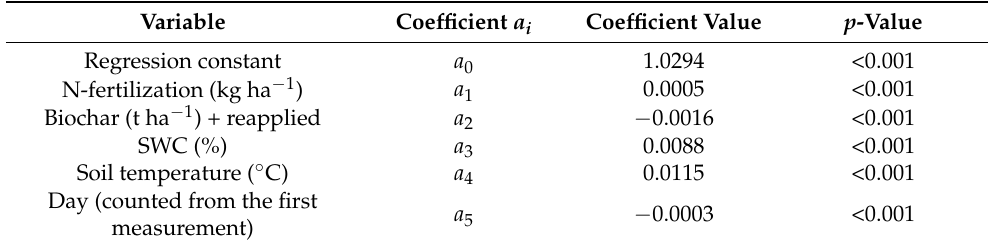
Table 5. Multivariate linear regression coefficients and p –values. The dependent variable was log 10 (N 2 O + const). Variable Coefficient a i p